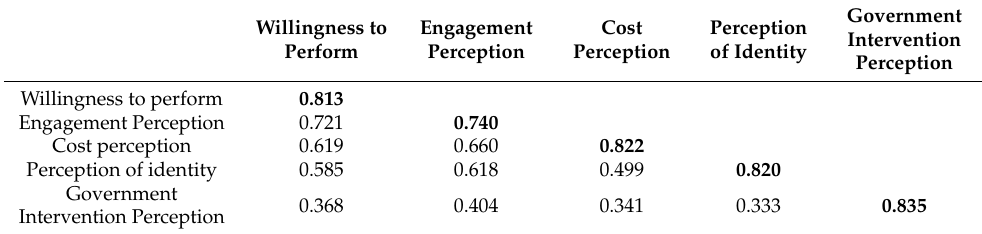
Table 10. Discriminant validity analysis